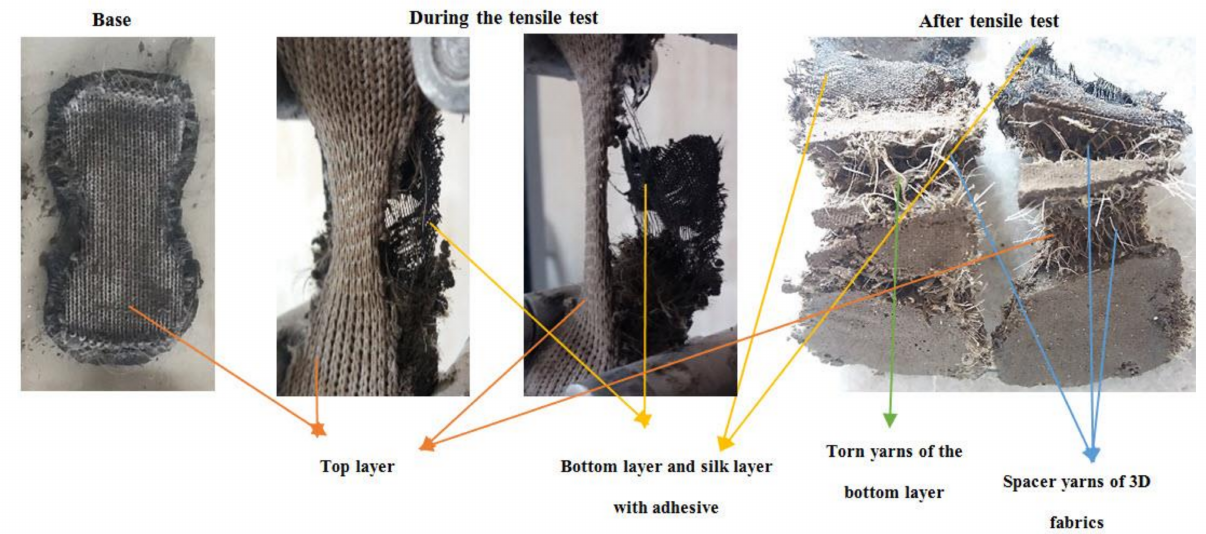
Figure 8. The tensile performance of reinforced cementitious composite.